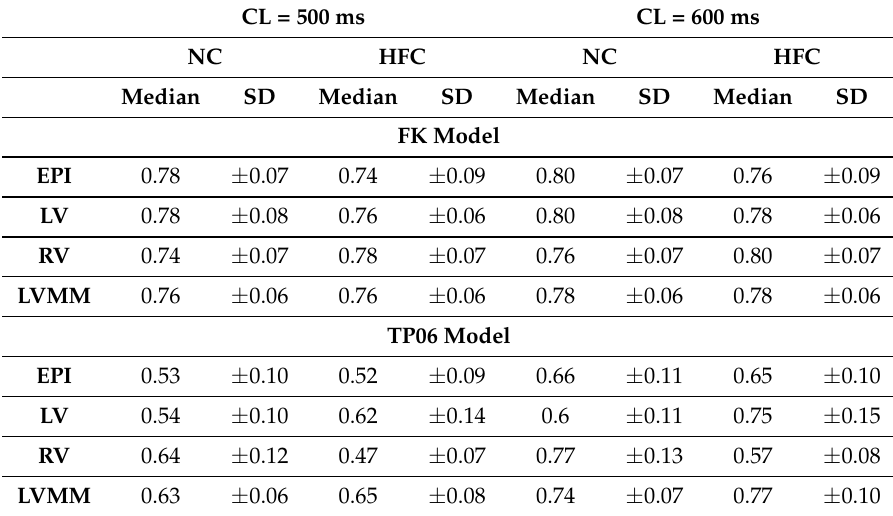
Table A4. Medians and standard deviations (SD) for the FK model and the TP06 model at CL = 500ms and CL = 600ms,